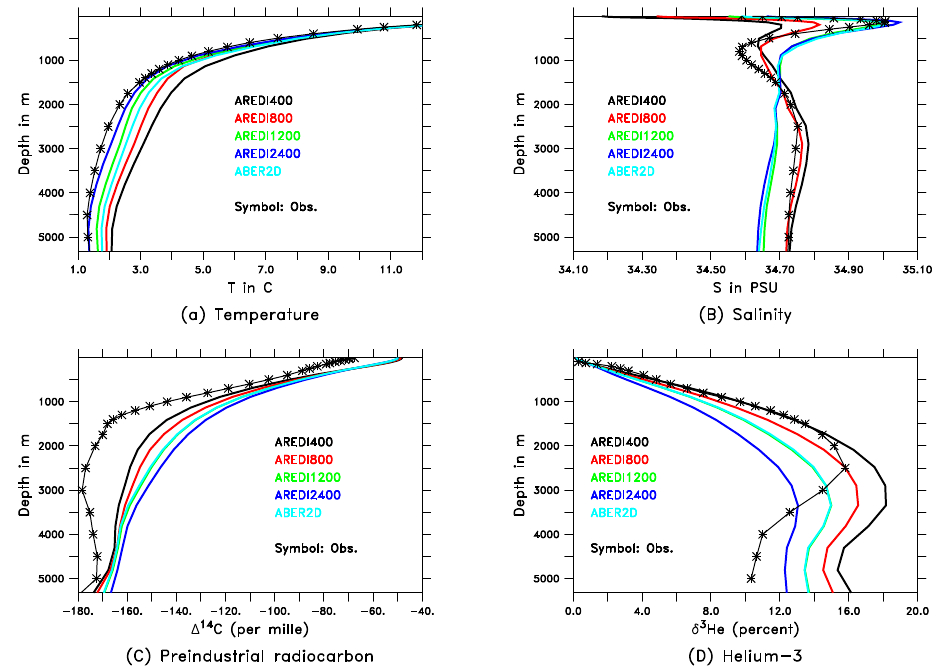
Figure 4. Mean hydrography in the Earth system model suite. (a) Temperature, compared with the World Ocean Atlas. (b) Salinity compared with the World Ocean Atlas. (c) Radiocarbon, compared with Key et al. (2004). (d) Helium isotope anomaly compared with Bianchi et al.